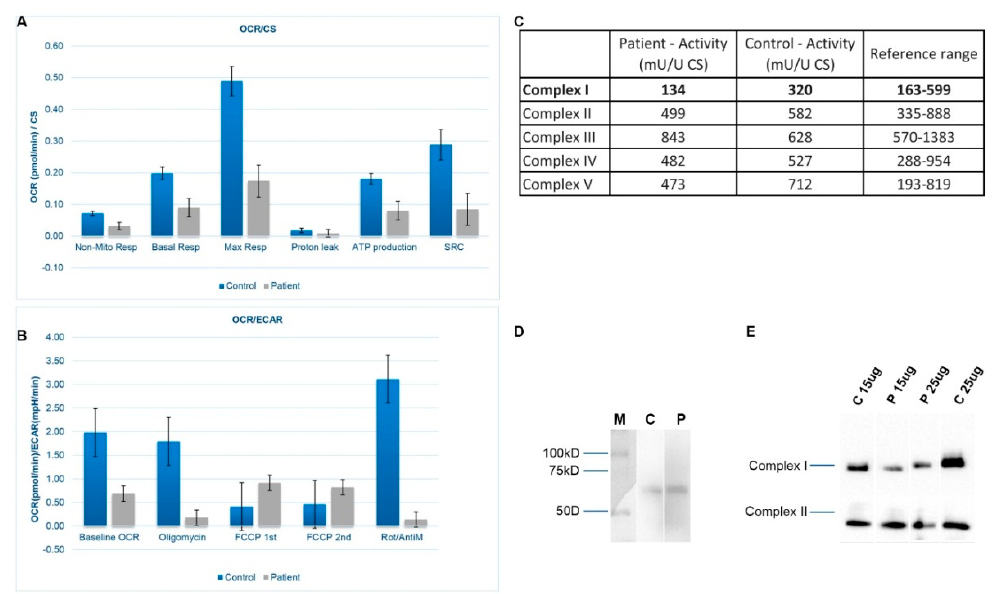
Figure 3. ( A ) Oxygen Consumption Rate (OCR) is measured before and after the addition of inhibitors. The Seahorse XF Cell Mito Stress Test uses compounds of respiration that target components of the Electron Transport Chain (ETC) in the mitochondria to reveal key parameters of metabolic function. These modulators are ETC inhibitors (oligomycin, FCCP, and a mix of rotenone and antimycin A) which were serially injected to measure ATP (adenosine triphosphate) production, maximal respiration (Max Resp), non-mitochondrial respiration (Non-Mito Resp), proton leak, spare respiratory capacity (SRC) and basal respiration (Basal Resp). ( B ) The basal energy metabolism of each cell line was assessed by analyzing OCR/ECAR ratios through sequential injections of the inhibitors. ( C ) Measurement of enzyme activities for the different oxidative phosphorylation system (OXPHOS) complexes in patient and control fibroblasts. FOXRED1 migrated at its predicted size of 54 kDa. CS—Citrate synthase. ( D ) SDS-PAGE immunodetections of FOXRED1 in control and patient fibroblasts. (M) Marker, (C) Control, and (P) Patient. Blot was cropped from different parts of the same gel to show results from samples of interest. A full-length gel is included in Supplementary Material. ( E ) One-dimensional Blue-Native polyacrylamide gel electrophoresis (BN-PAGE) analysis of complex I in gel activity and western blot immunodetection showing differences in complex I amount between control (C) and patient (P) fibroblasts. Blot was cropped from different parts of the same gel to show results from samples of interest. A full-length gel is included in Supplementary Material.